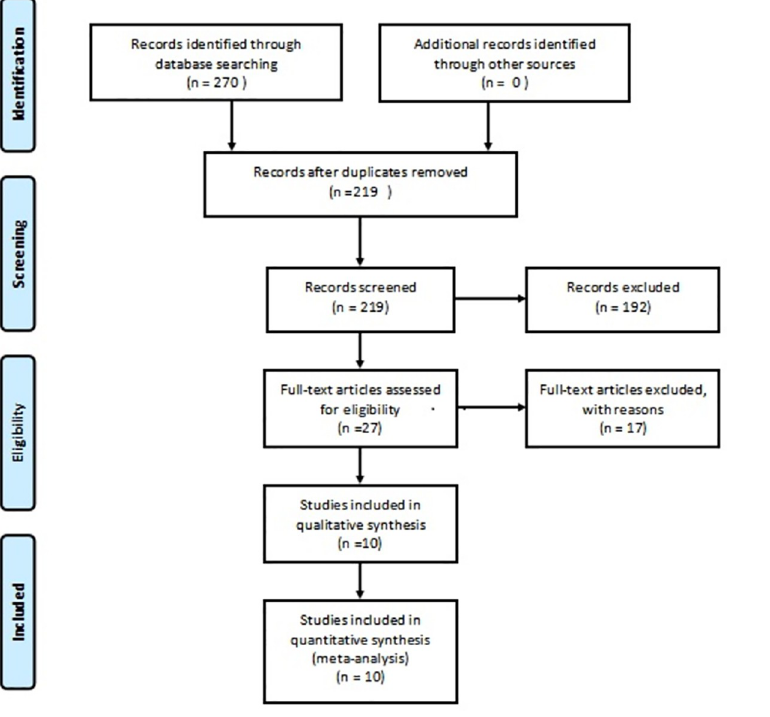
Fig 1. Literature retrieval and selection